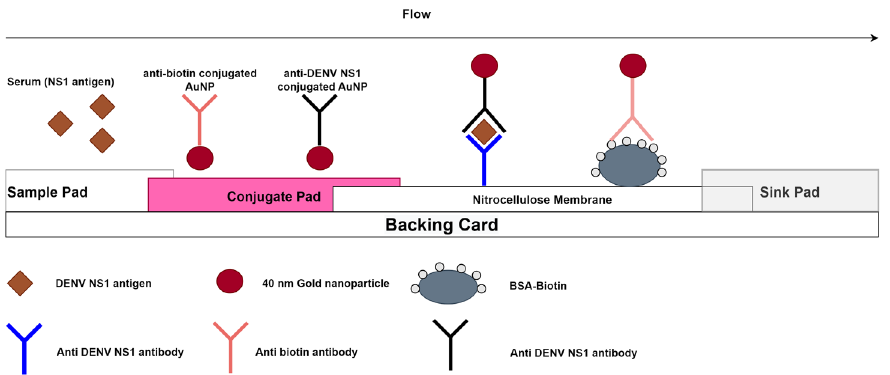
Figure 1. Schematic illustration of the Dengue NS1 rapid antigen test.